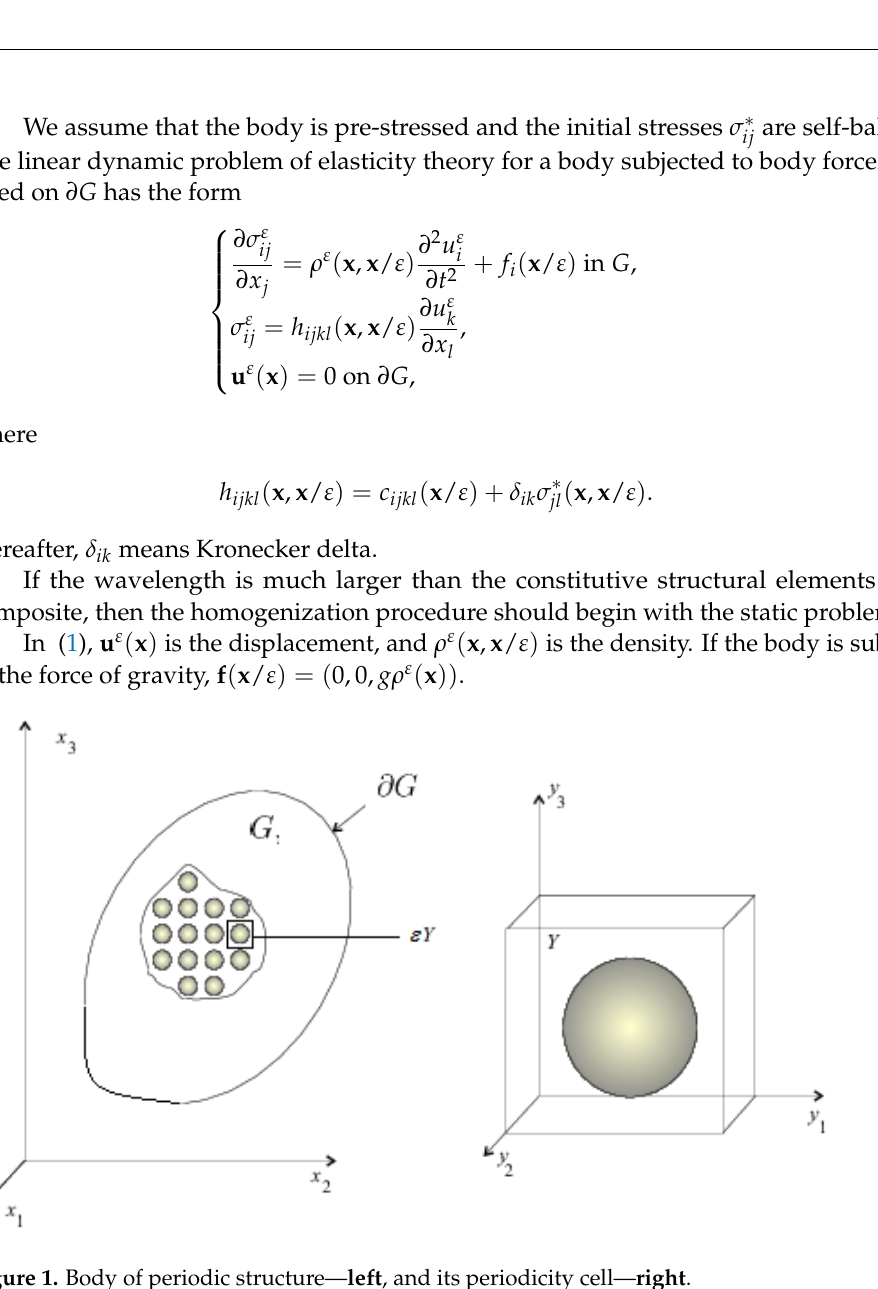
Figure 1. Body of periodic structure— left , and its periodicity cell— right